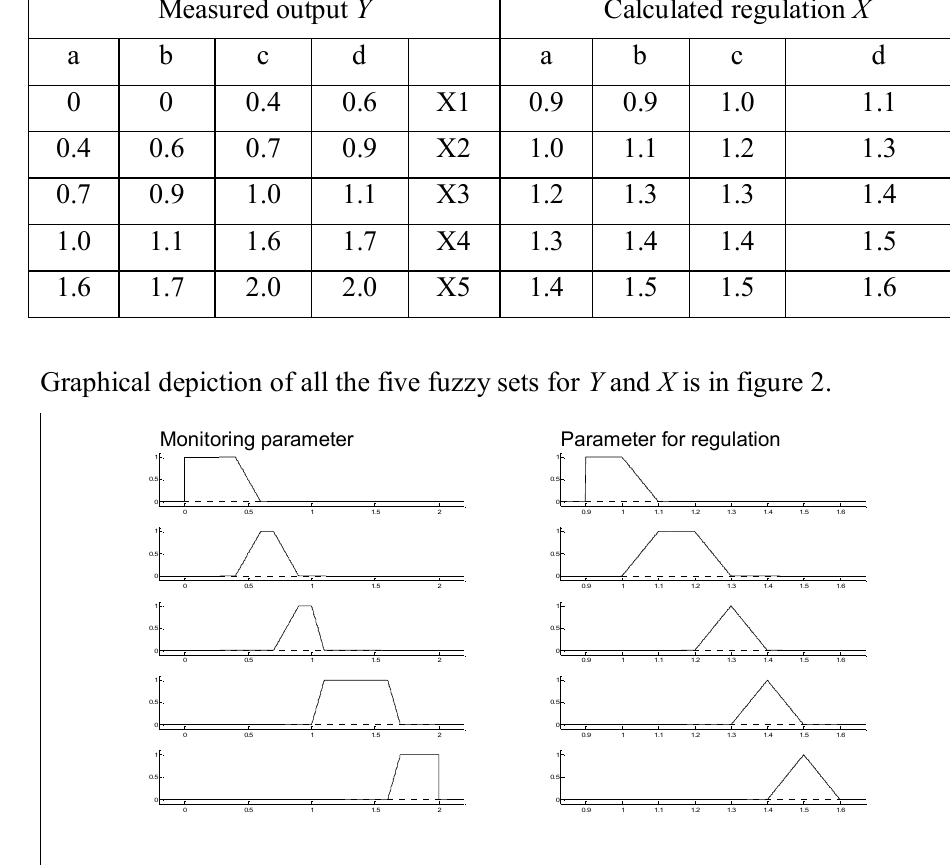
Figure 2 – Regulation rules based on table